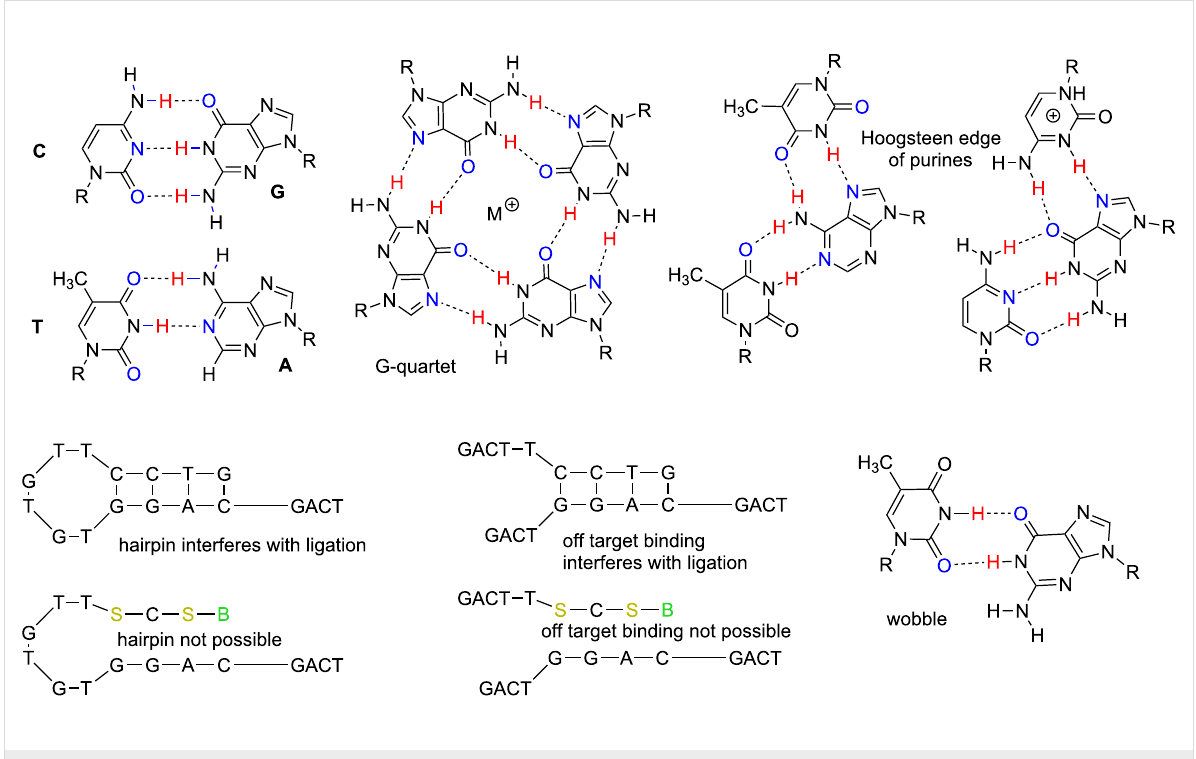
Figure 1: Structures explaining why large DNA (L-DNA) constructs cannot easily autonomously self-assemble from many synthetic single-stranded DNA oligonucleotides. Clockwise from top left, the strong C:G and weak T:A pairs complicate design. G-quartets can arise from G-rich sequences. Major groove interactions involving hydrogen bonding to the “Hoogsteen edge” of purines can compete with Watson–Crickery. Wobble pairs allow formal mismatches to nonetheless contribute to duplex stability, depending on context. The low information density of four-nucleotide DNA allows easy off-target hybridization and unimolecular formation of hairpins. Unimolecular processes (like hairpin formation) compete with the desired inter- molecular hybridization especially effectively at low concentrations of oligonucleotide. Adding components of an artificially expanded genetic informa- tion system (AEGIS, here S and B ) prevent a class of these obstructive